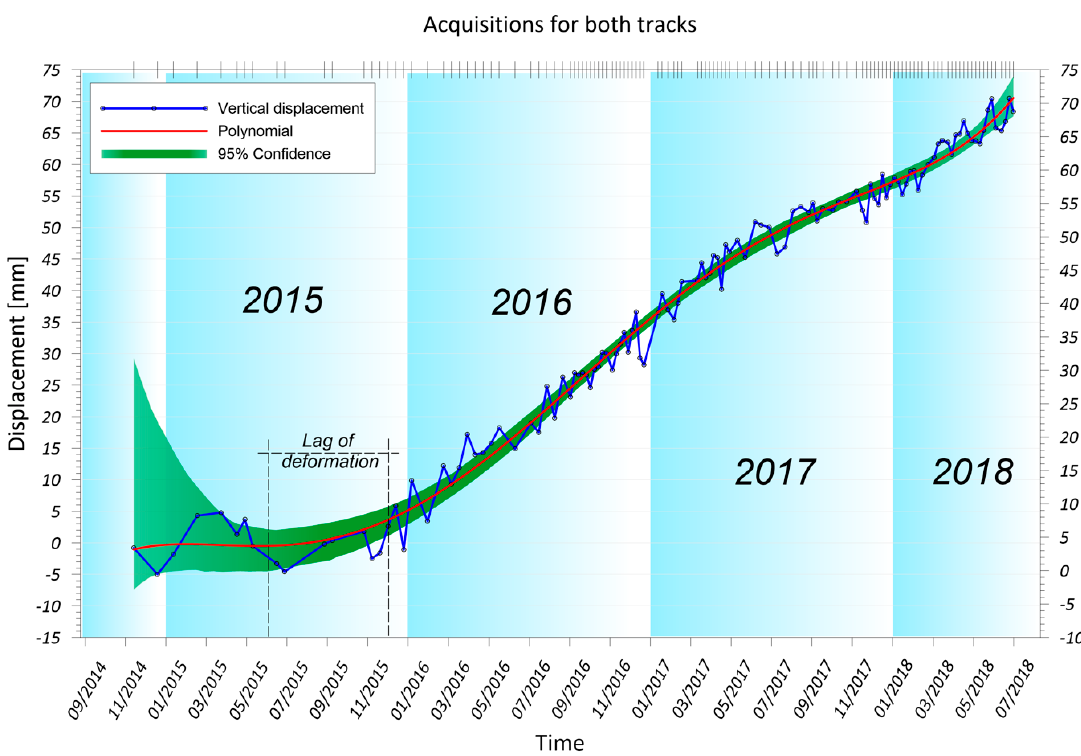
Figure 7. Time series of selected PS points. The blue line represents the time series for the selected PS (Point B) with the highest cumulative displacement value, see Figure 6 for location.